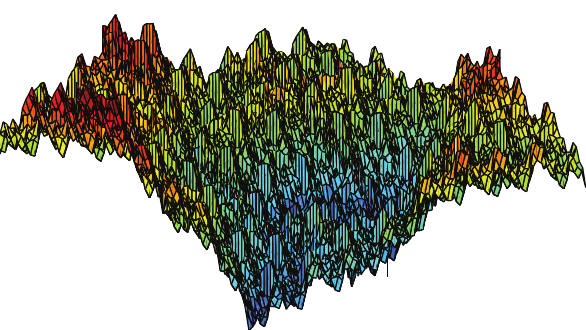
Figure 1: Fractal interpolation curve.